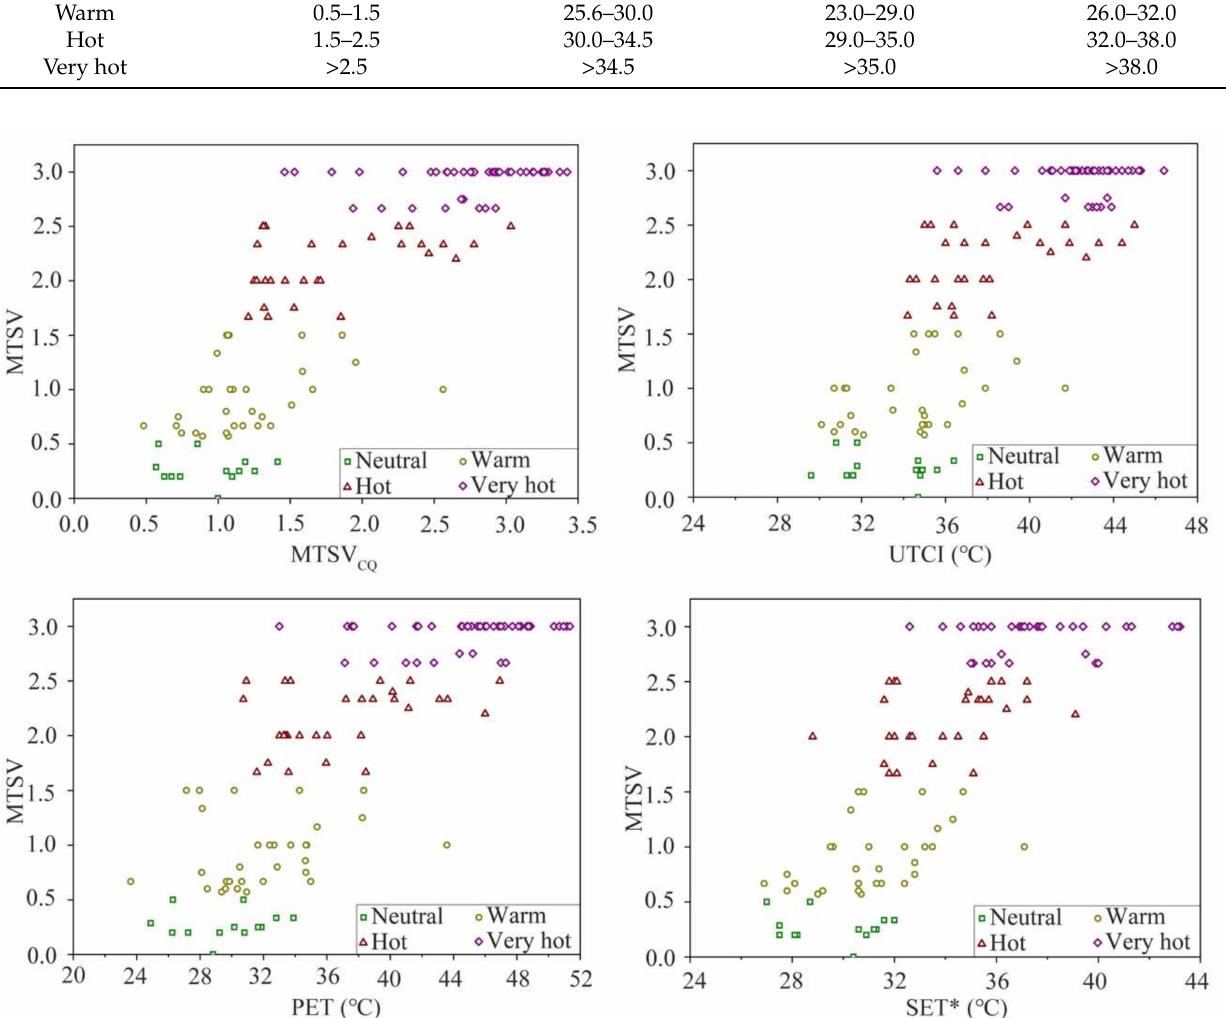
Figure 7. Accuracies of four thermal indices in predicting outdoor MTSV of Chongqing